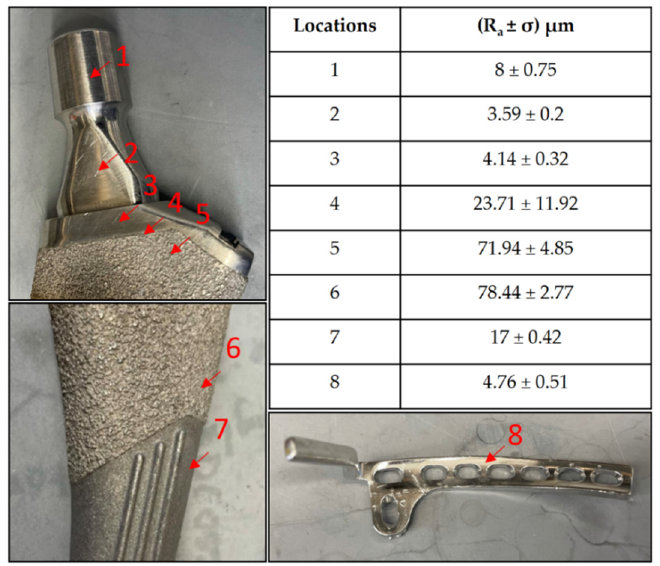
Figure 1. Roughness values at different surfaces on a femoral hip stem and fixation plate.